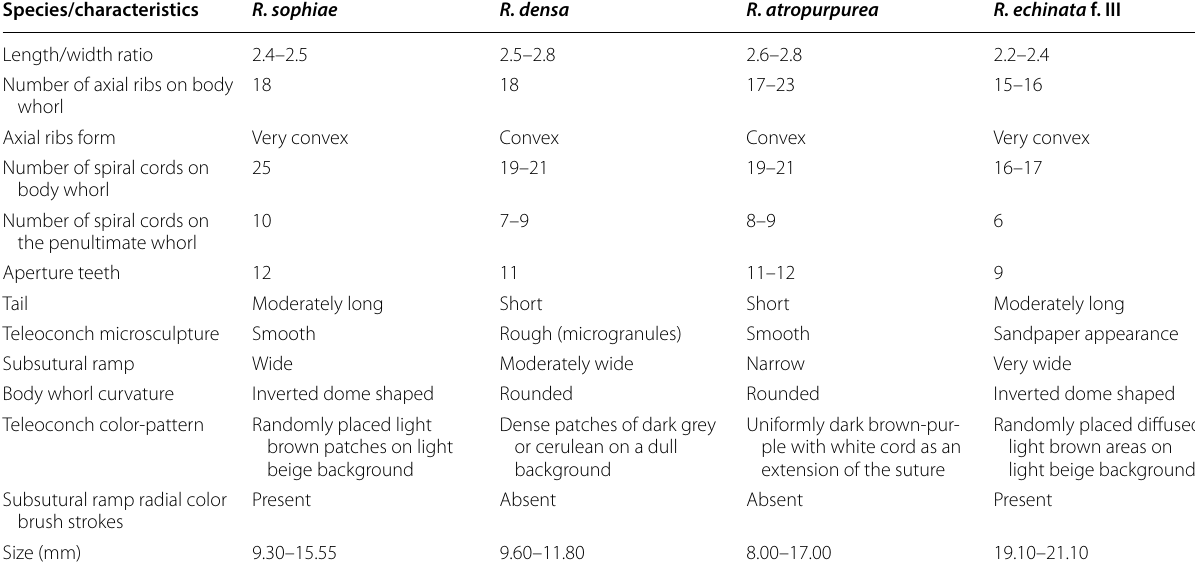
Table 2 Comparison of Raphitoma sophiae n. sp. characteristcs of mature specimens against those of R. densa , R. atropurpurea and R. echinata f.